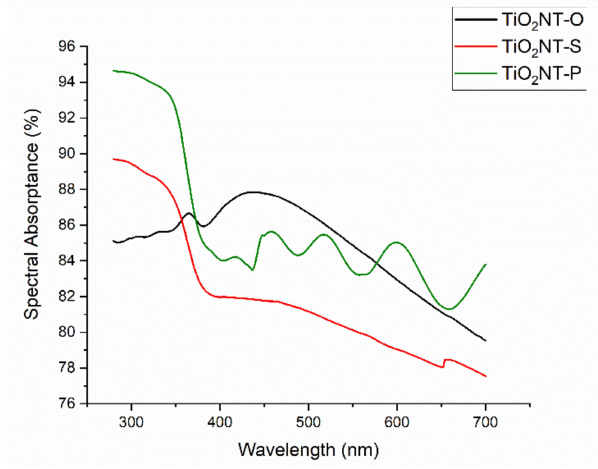
Figure 4. Spectral absorptance of the three nanotube arrays. Table 2. Spectral absorptance of the different nanotube arrays.